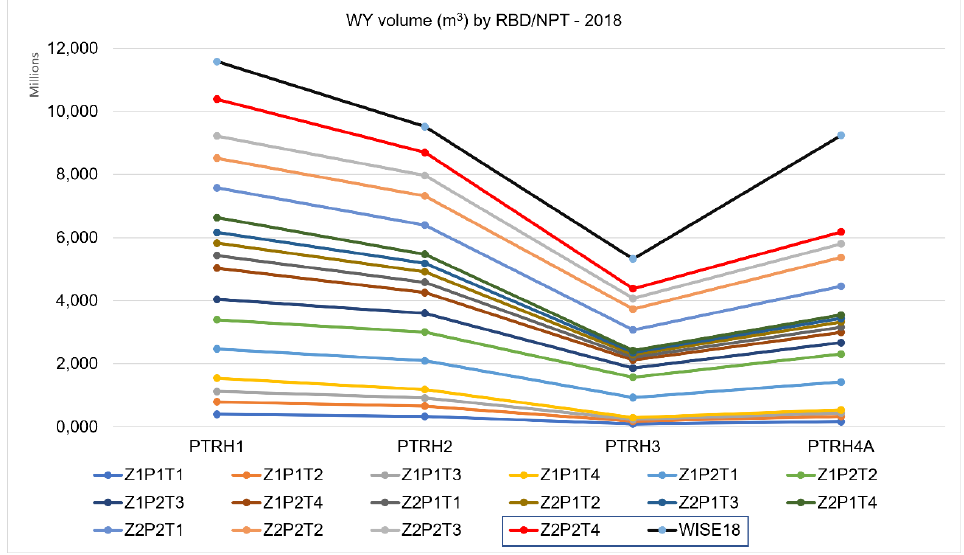
Figure 12. Estimated WY volume (m3) in 2018 by RBD/NPT sector and observed values. In the SPT sector (Figure 13) the best simulation was considering the test Z1P1T4. The differences between these two tests are on the number of rain days considered, and the source of the precipitation data.